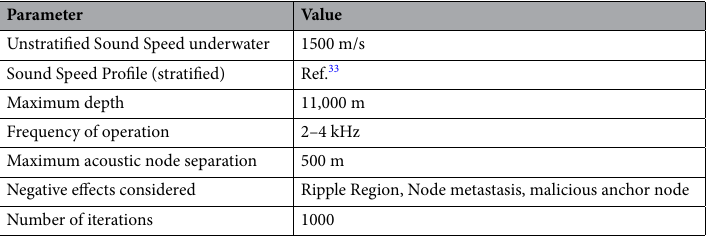
Table 2. Parameters of GSA model.